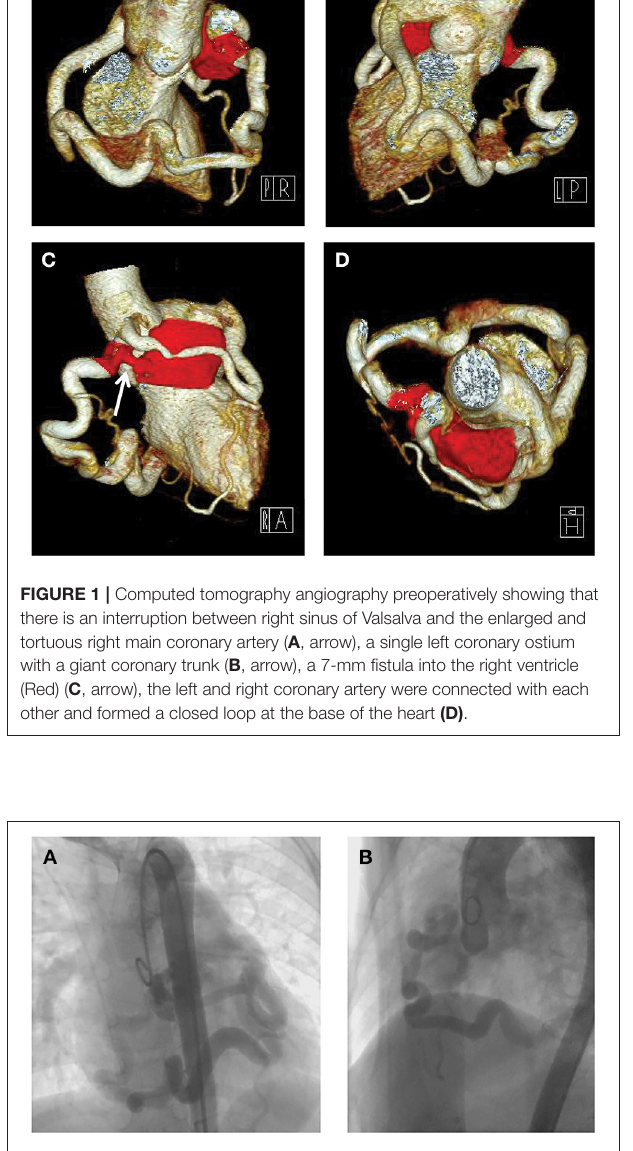
FIGURE 2 | Ascending aortic angiography preoperatively showing that the left and right coronary artery were enlarged and tortuous (A) , right coronary artery was detected secondly to the left one (B) , confirming the diagnosis of coronary artery ring with single left coronary ostium and